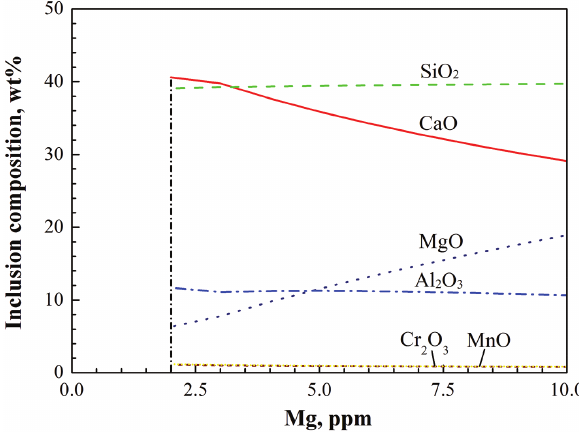
Figure 8: Composition of inclusions as a function of Mg content by using FactSage